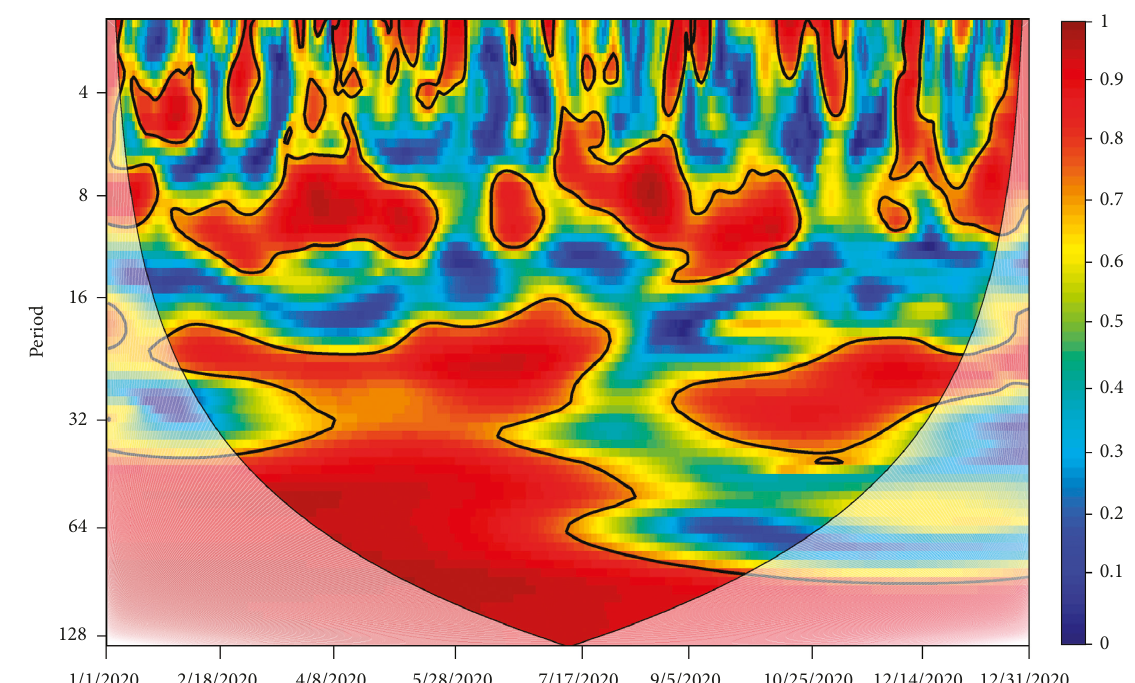
Figure 10: The combined effects of EPU and IDEMV on illiquidity (pandemic period). Note: this figure represents the combined effects of EPU and IDEMV on illiquidity during pandemic period. The black contour represents the regions in which the spectrum is significant at the 5% level against red noise. The cone of influence denoted as COI is designated by the lighter shade which delineates the high power regions. Time and scale (days) are represented on the horizontal and vertical axes, respectively. Arrows pointed to the right (resp. left) signify that the variables are in phase (out of phase). If arrows move to the right and up (resp. down), the first variable is the driver (resp. follower). By contrast, if arrows move to the left and up (down), the second variable is leading (resp.